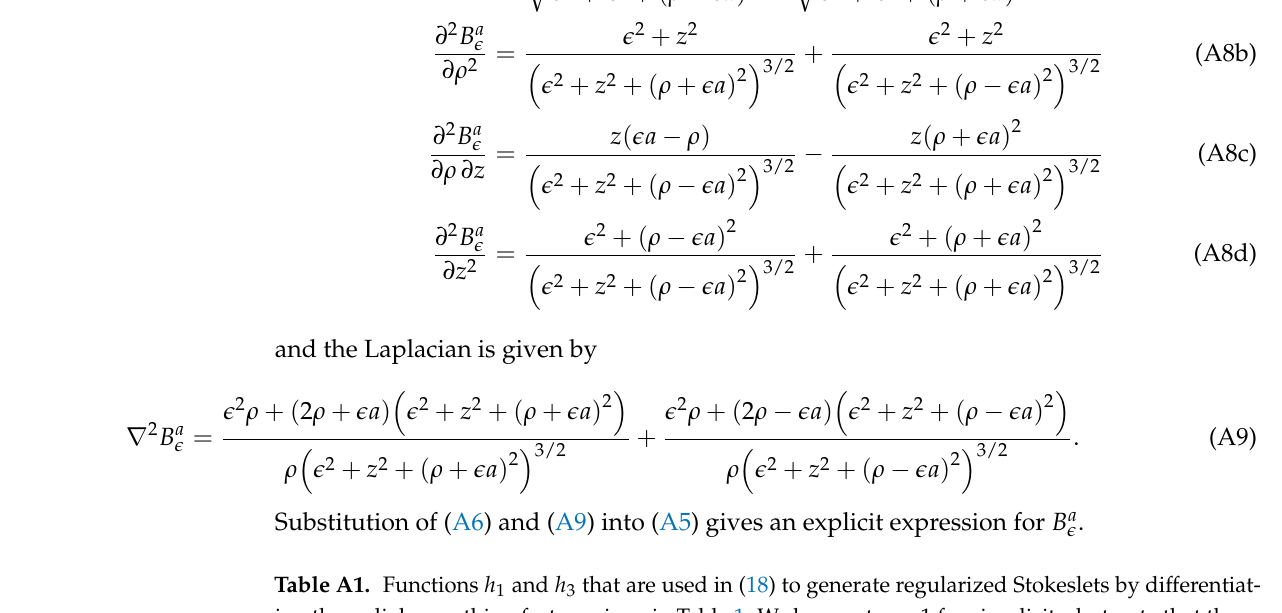
Table A1. Functions h 1 and h 3 that are used in (18) to generate regularized Stokeslets by differentiat- ing the radial smoothing factors given in Table 1. We have set (cid:101) = 1 for simplicity, but note that